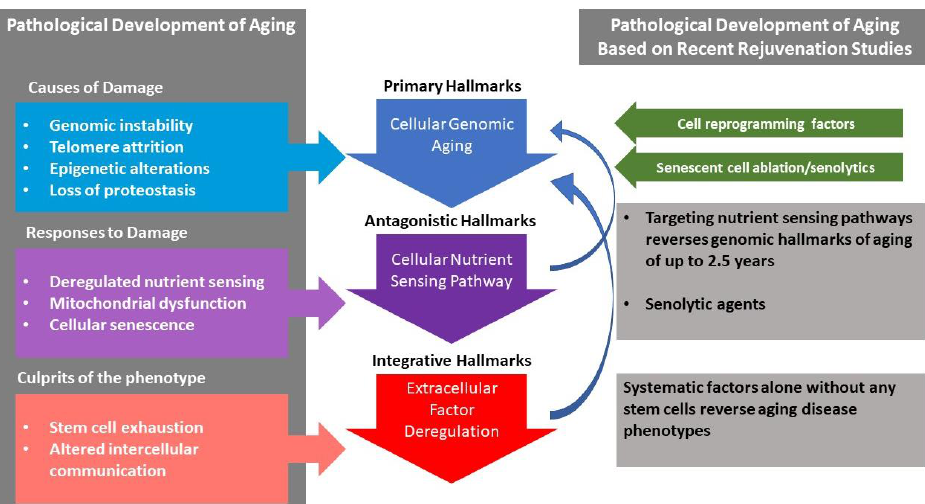
Figure 2. The pathology of aging and the causative relationship between its hallmarks. An illustra- tion of the differences between theoretical assumptions regarding the hierarchical order of the aging process [39] and the various experimental avenues that show the complex relationship between the various hallmarks of aging. These include targeting nutrient sensing pathways [6,7,44 – 47], circulat- ing factors and young plasma [48 – 51], senescent cell ablation [52 – 56] and cell programming factors